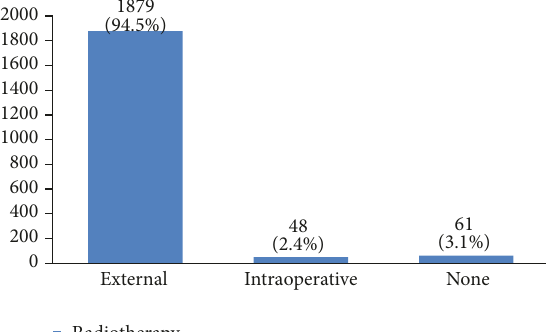
Figure 31: The radiotherapy type in the studied cases.